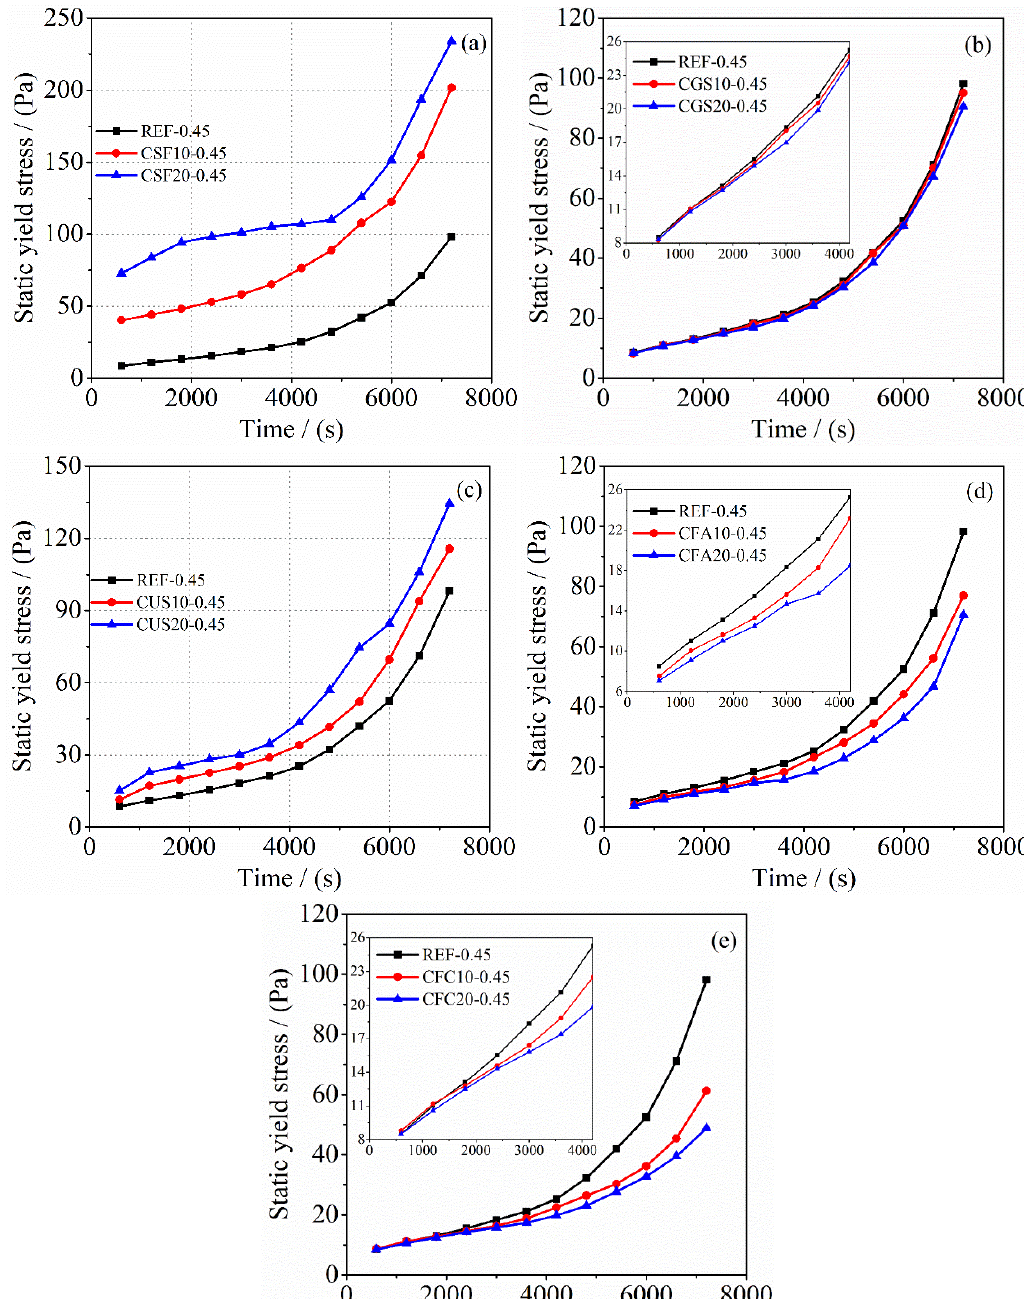
Figure 6. Effect of mineral admixtures on the evolution of static yield stress of common pastes: ( a ) CSF-0.45, ( b ) CGS-0.45, ( c ) CUS-0.45, ( d ) CFA-0.45, ( e ) CFC-0.45. ( a ) CSF-0.45, ( b ) CGS-0.45, ( c ) CUS-0.45, ( d ) CFA-0.45, ( e )